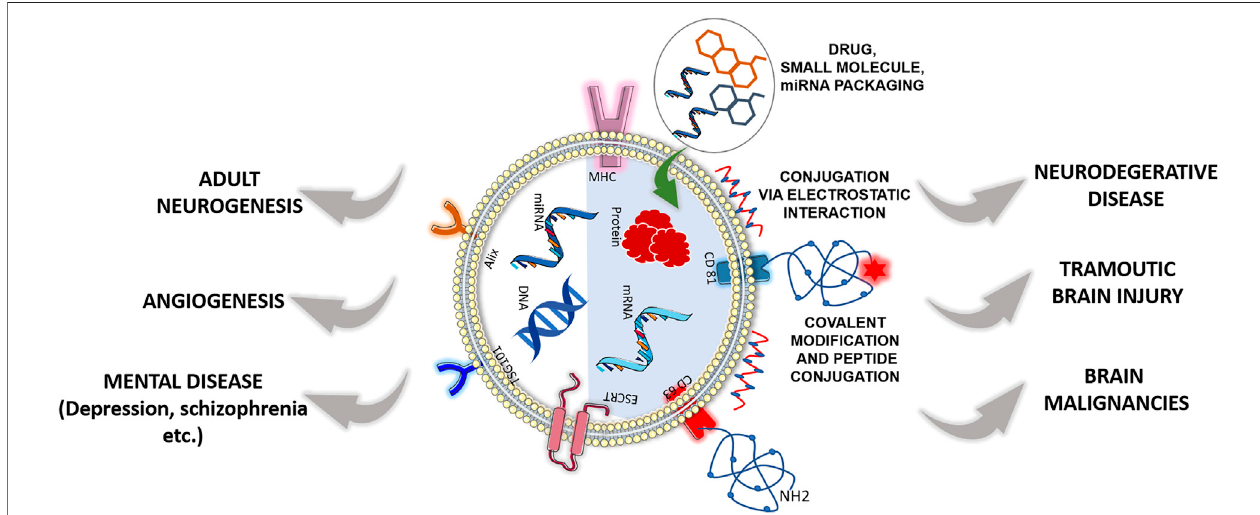
FIGURE 5 | Therapeutic effect of designer exosomes or cell-derived natural exosomes in neurological disorders. The left half of the exosome represents cell- derived natural exosome, and the right half represents surface-functionalized engineered exosome. Both cell-derived and engineered exosomes have a therapeutic effect in neurological disorders with advantages and disadvantages. [Some component of the fi gure is adapted from Servier Medical Art; Servier is licensed under a creative commons attribution 3.0 unported license